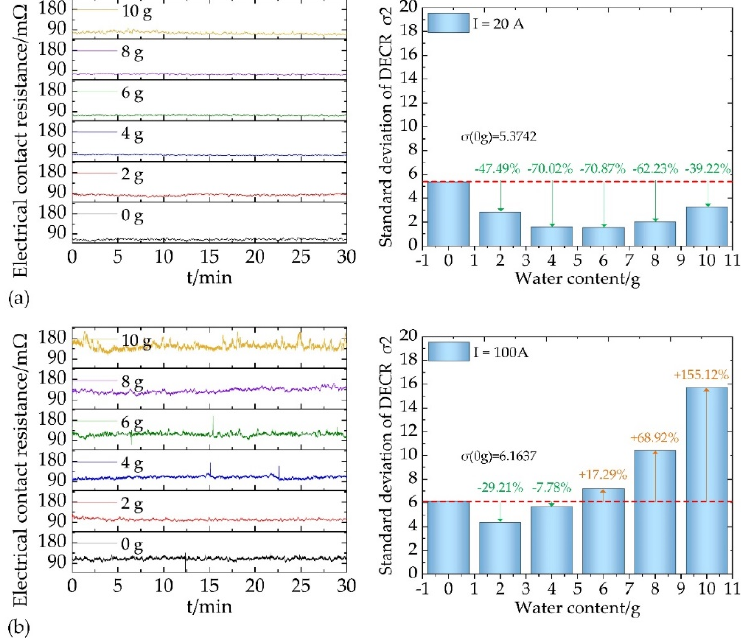
Figure 6. Effect of water content on the DECR of C-Cu contacts: ( a ) at 20 A; ( b ) at 100 A.